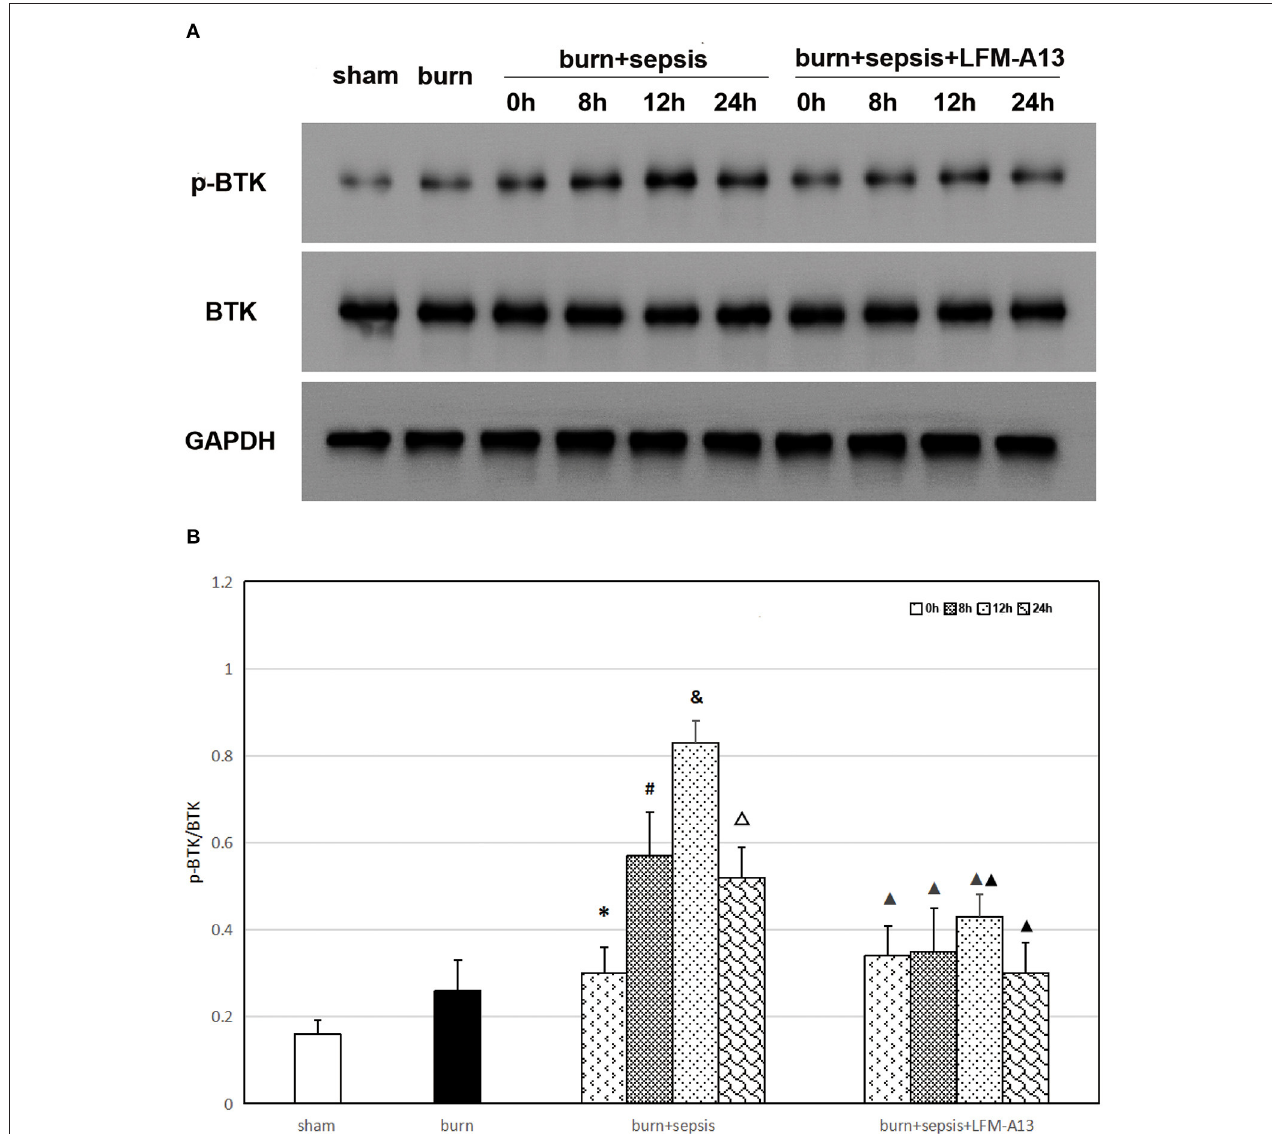
FIGURE 1 | Expression levels of total BTK and p-BTK in intestinal tissue. (A) A representative western blot image of total BTK protein and p-BTK in each group. (B) The expression level of p-BTK (p-BTK /BTK) in each group at different time points of postburn. * P < 0.05, vs. the sham group and burn group; in the burn + sepsis group, # P < 0.05, vs. 0h; & P < 0.05, vs. 8h; 1 P < 0.05, vs. 12h; N P < 0.05, NN P < 0.01, vs. the burn + sepsis group at corresponding time points except 0h of